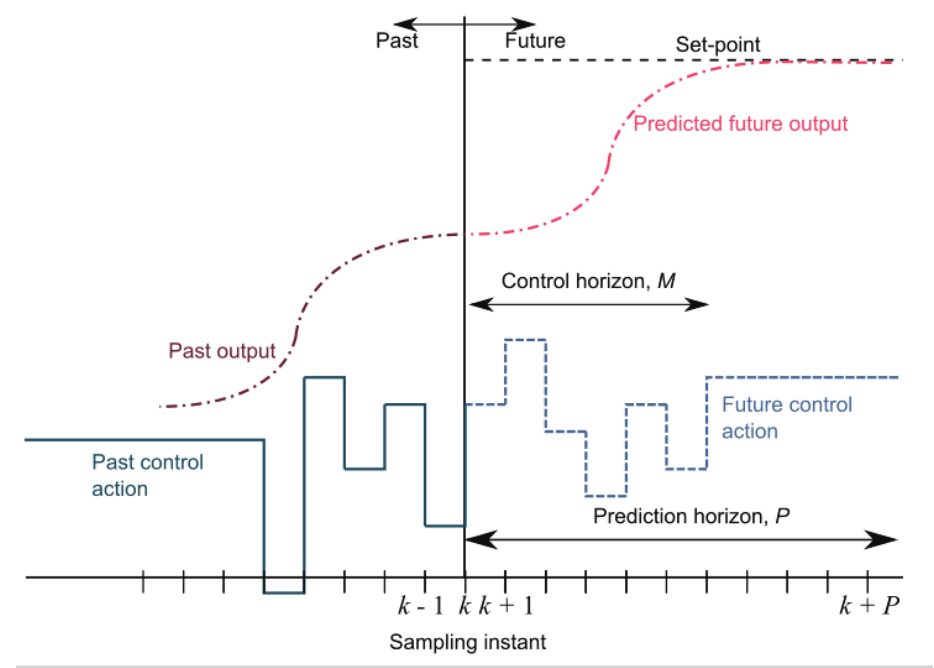
Fig. 3 – Scheme of an